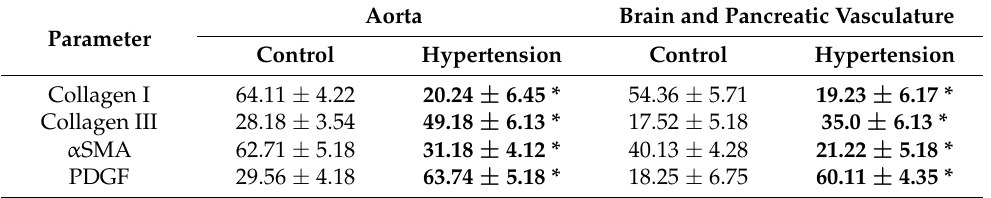
Table 2. Scoring of immunohistochemical findings in the aortic, brain, and pancreatic vasculature. Since the responses of the brain and pancreatic vessels were similar, they were presented together. Significant differences were observed between the control and hypertensive group in all of the tested tissues ( p < 0.05). Aorta Brain and Pancreatic Vasculature Parameter Control Hypertension Collagen I